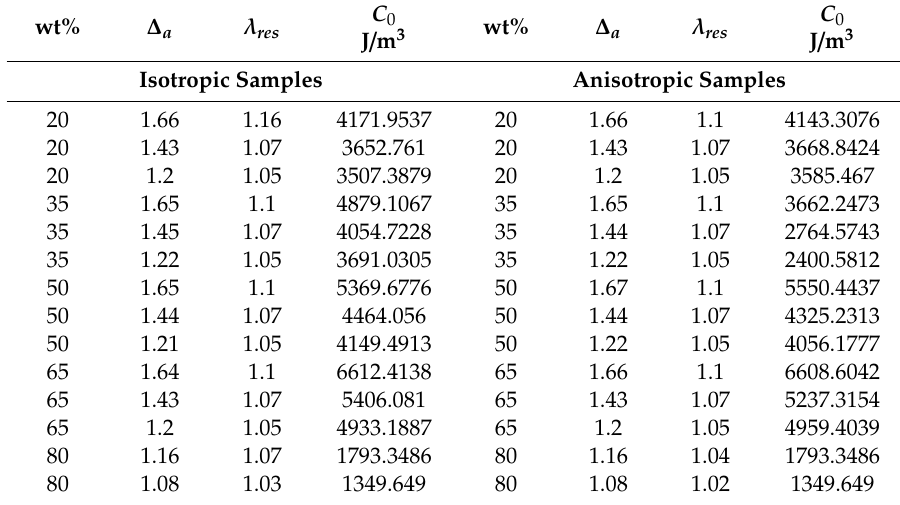
Table 3. Estimated material constant values of C 0 obtained by fitting experimental data. The listed values of ∆ a and λ res were recorded for each loading–unloading cyclic experimental test with B = 0 mT. C 0 wt% ∆ a λ res J / m 3